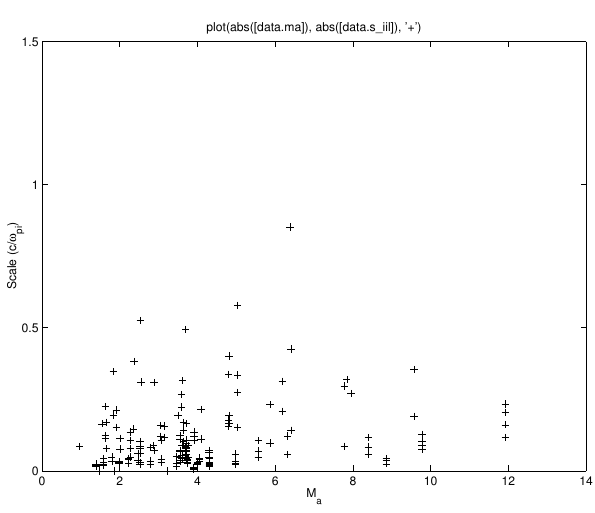
Fig. 11. Scatter plot showing the relationship between the ampli- tude of the electric field spikes as a function of Mach number. The red crosses are used to highlight the data for the shocks that oc- curred on 31 March